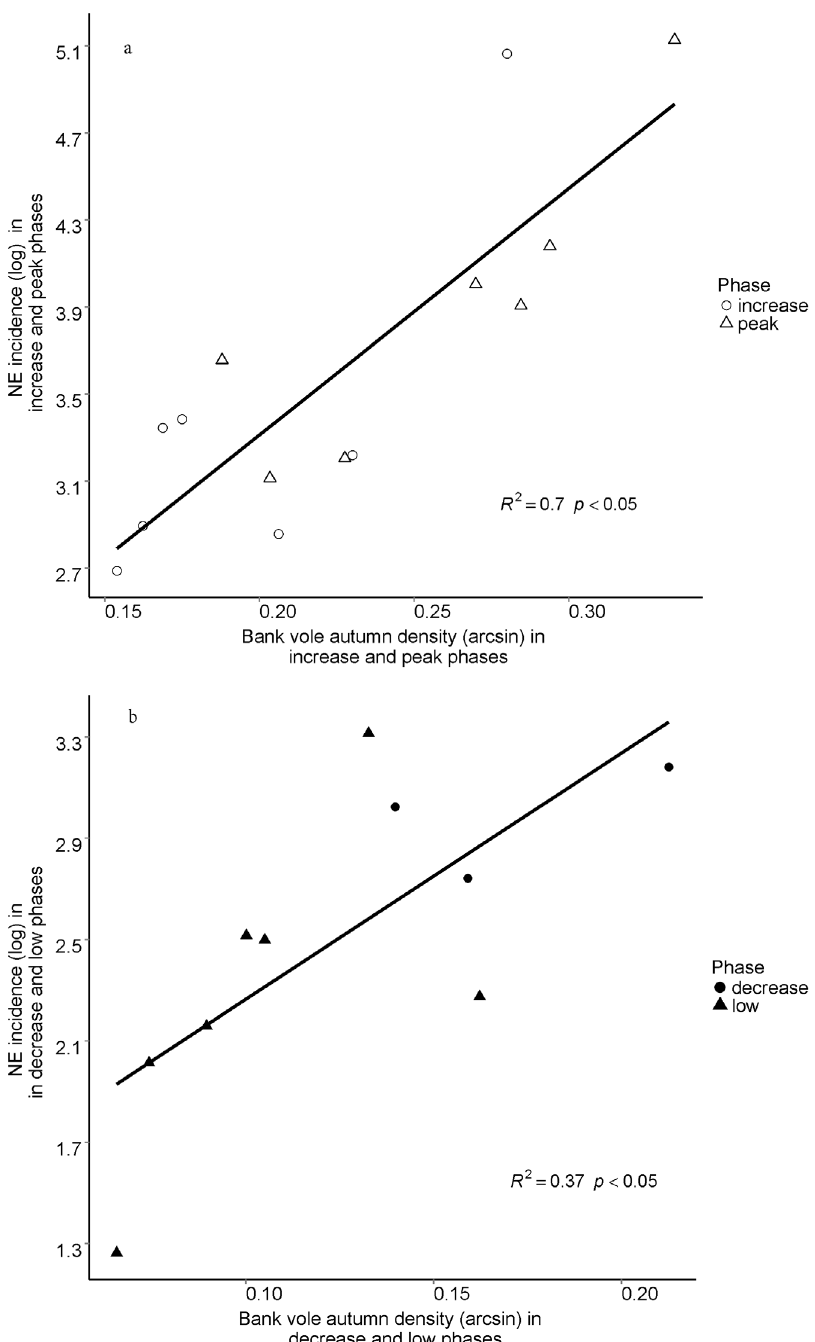
Figure 3. Relationship between annual (July–June) nephropathia epidemica incidence (NE) (log-transformed) in Northern Sweden and bank vole autumn density (number of trapped individuals per 100 trap nights) (arcsine transformed) during a) increase and peak years (n=13) and b) decrease and low years (n=11) of the vole cycles in 1990–2012.